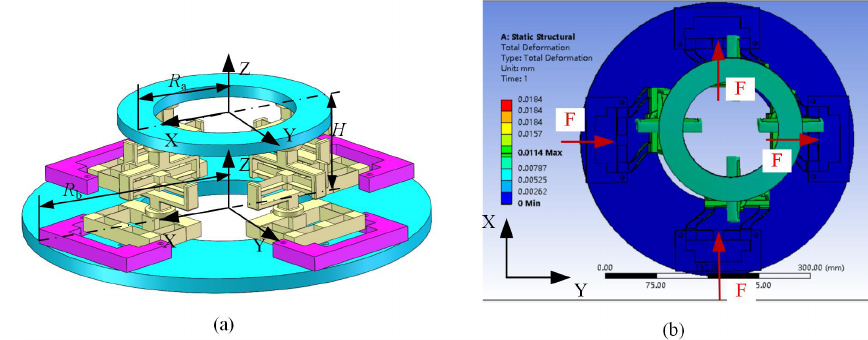
Figure 8. (a) The 4 − P i P j U ij compliant parallel mechanism. (b) The deformation distribution of the 4 − P i P j U ij